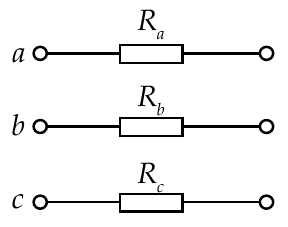
Figure 5. Circuit breaker model.